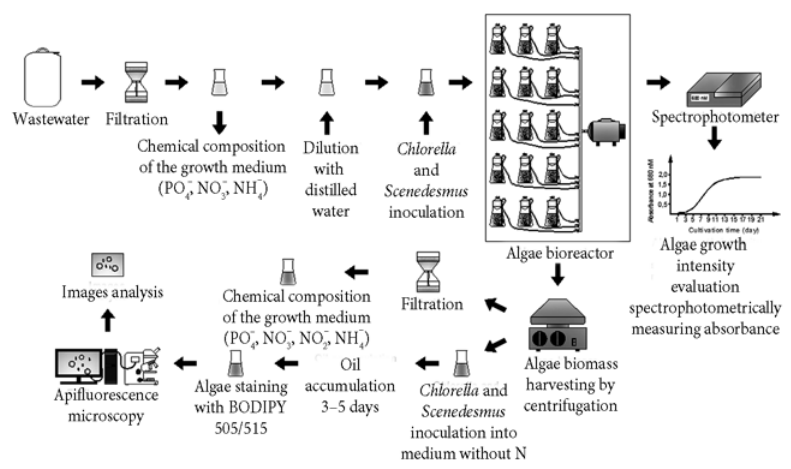
Fig. 1. The general scheme of the